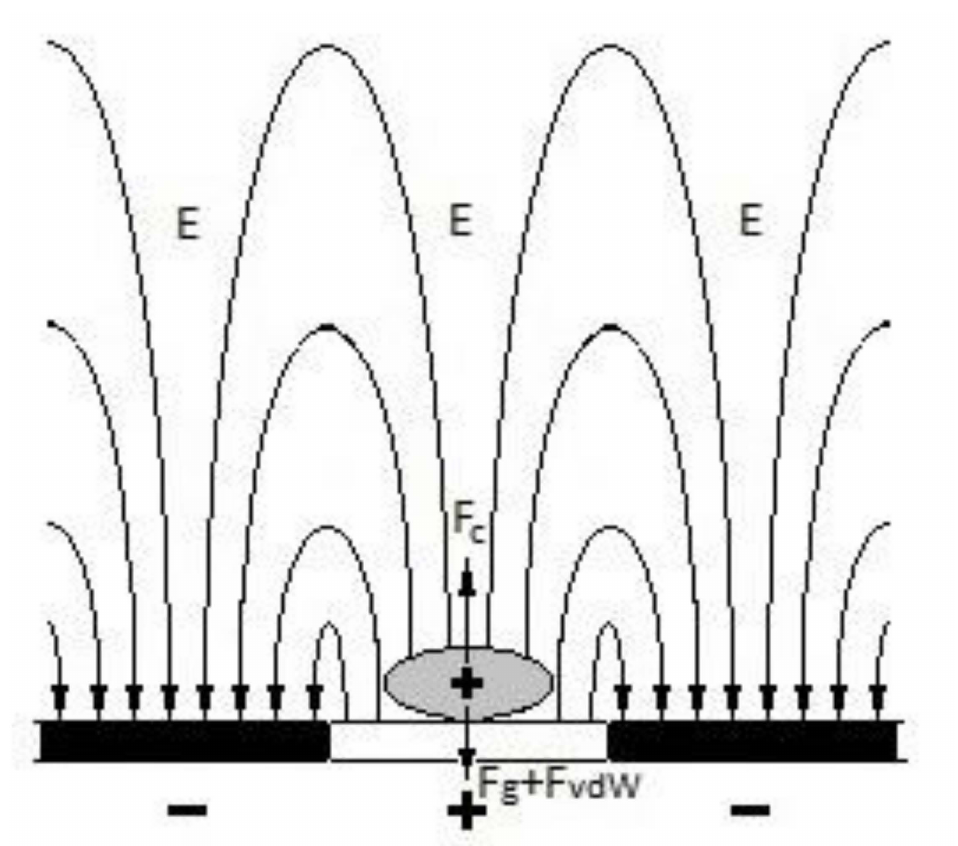
Figure 2. A dust particle is located in fluctuating areas on a dielectric surface. The charge sign of such a dust particle coincides with that of the region of its location. E corresponds to the field strength of the charge fluctuations field and has a horizontal